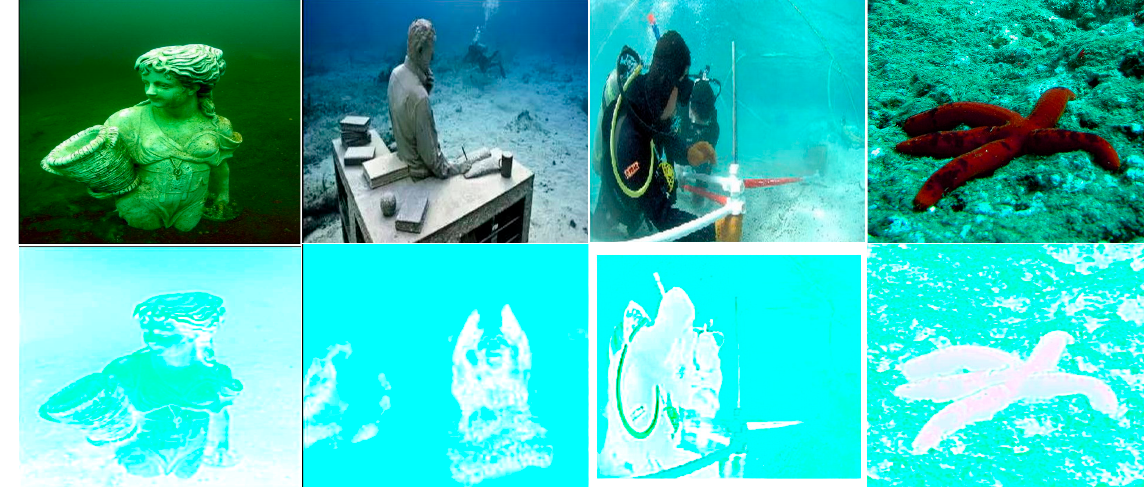
Figure 3. Visualization of the joint parameter map.